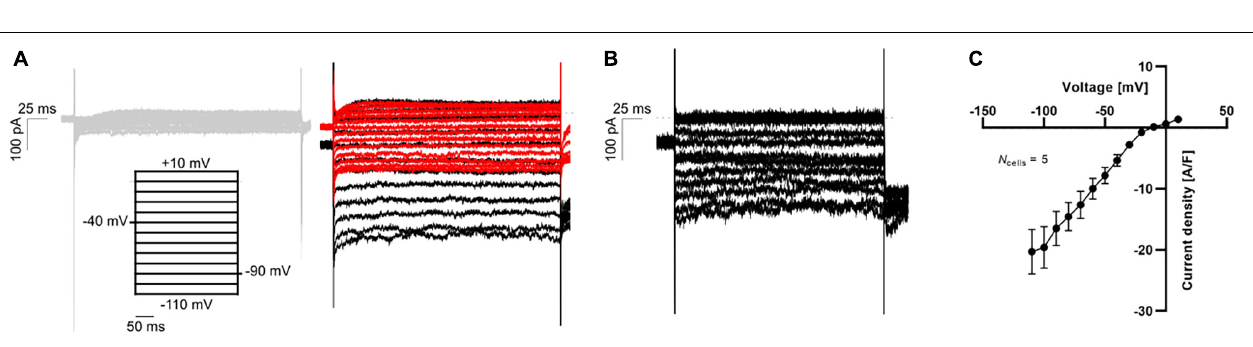
FIGURE 5 | Ion channel content in hiPSC-CMs versus human primary CMs. A comparison of action potential and ion channel currents recorded in (A) hiPSC-CMs and (B) human primary adult CMs. The associated genes and ion channels are listed on the right. From the top the currents are: I f , pacemaker or funny current; I CaT , T-type calcium channel current; I Na , sodium current; I CaL , L-type calcium channel current; I to , transient outward potassium current; I Kr , rapid delayed- rectifier potassium current; I Ks , slow delayed-rectifier potassium current; and I K1 , inward-rectifier potassium current. The traces highlight differences traditionally observed in hiPSC-CMs, such as the presence of the pacemaker current I f (routinely expressed in immature CMs and lost in adult CMs) and reduced densities of hyperpolarizing current I K1 . Adapted from Karbassi et al. (2020), with permission from publisher Springer Nature.